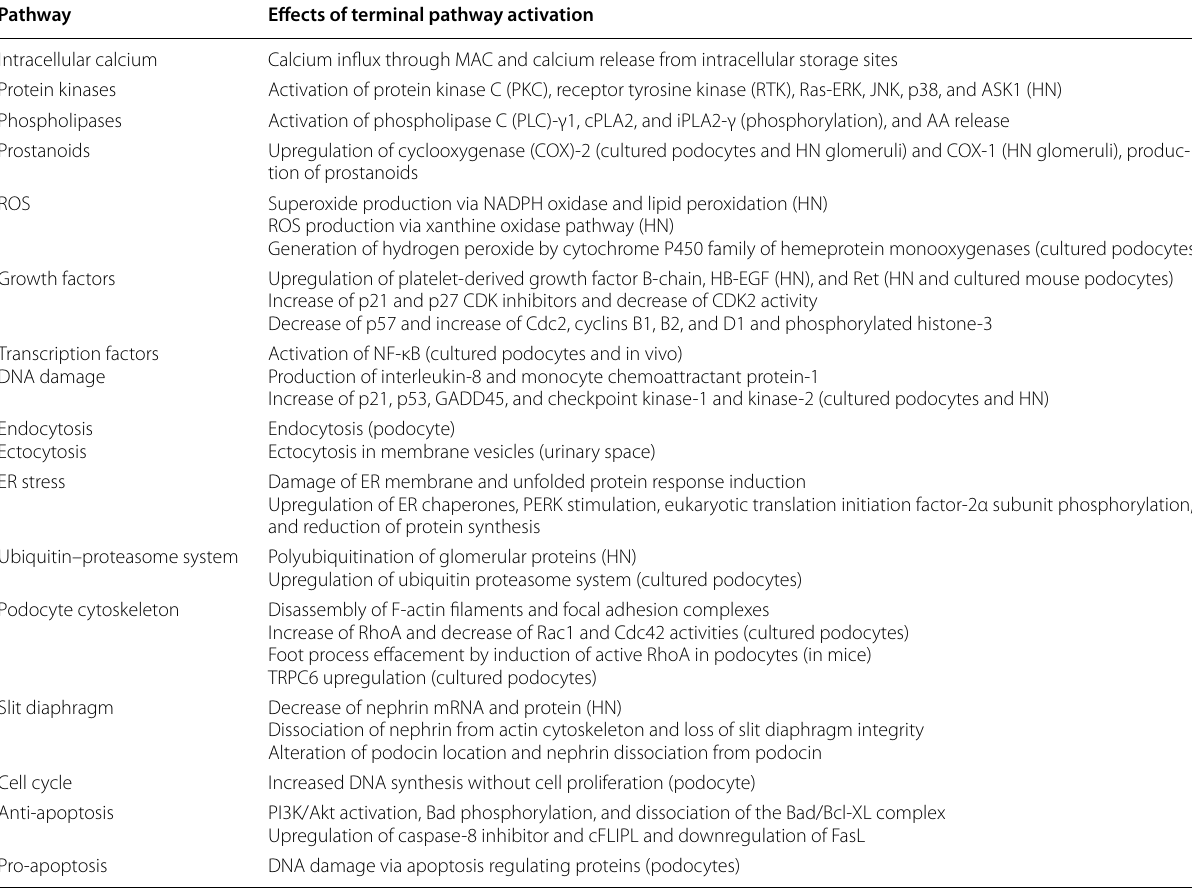
Table 2 Signalling pathways activated by MAC (adapted from Takano et al. (2013). Seminars in Nephrology. Reference